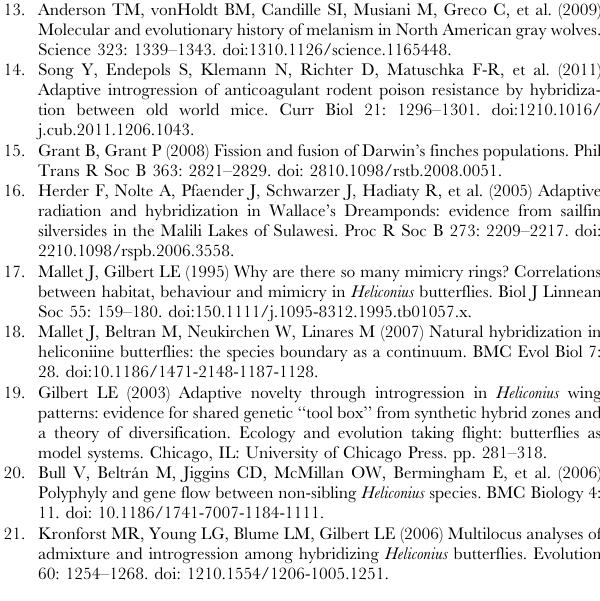
Figure S1 Schematic representation of the contrasting topolo- gies used in the SH test. (a) Species tree inferred from mtDNA and (b) ‘independent phenotypic convergence’ tree where red-banded (red cross) and rays (orange cross) evolved independently in H. tree, where H. melpomene acts as an ancestral red polymorphic taxa and H. cydno , H. heurippa and H. timareta are derived taxa where multiple retentions and losses (red crosses) of red traits have occurred. Figure S2 Pairwise linkage disequilibrium. Table S1 List of species, races, and specimens used. Table S2 Primers and PCR information. Table S3 Population size parameter estimated by